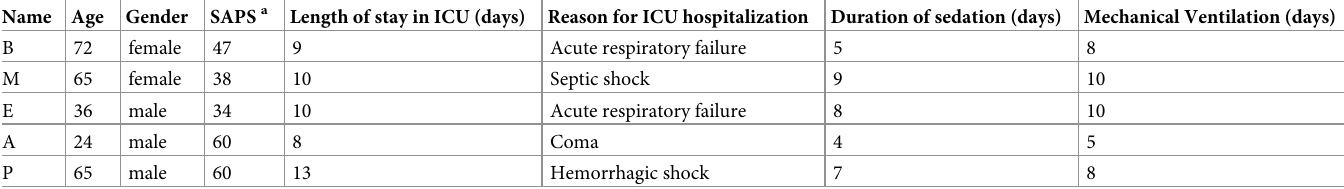
Table 1. Characteristics of the